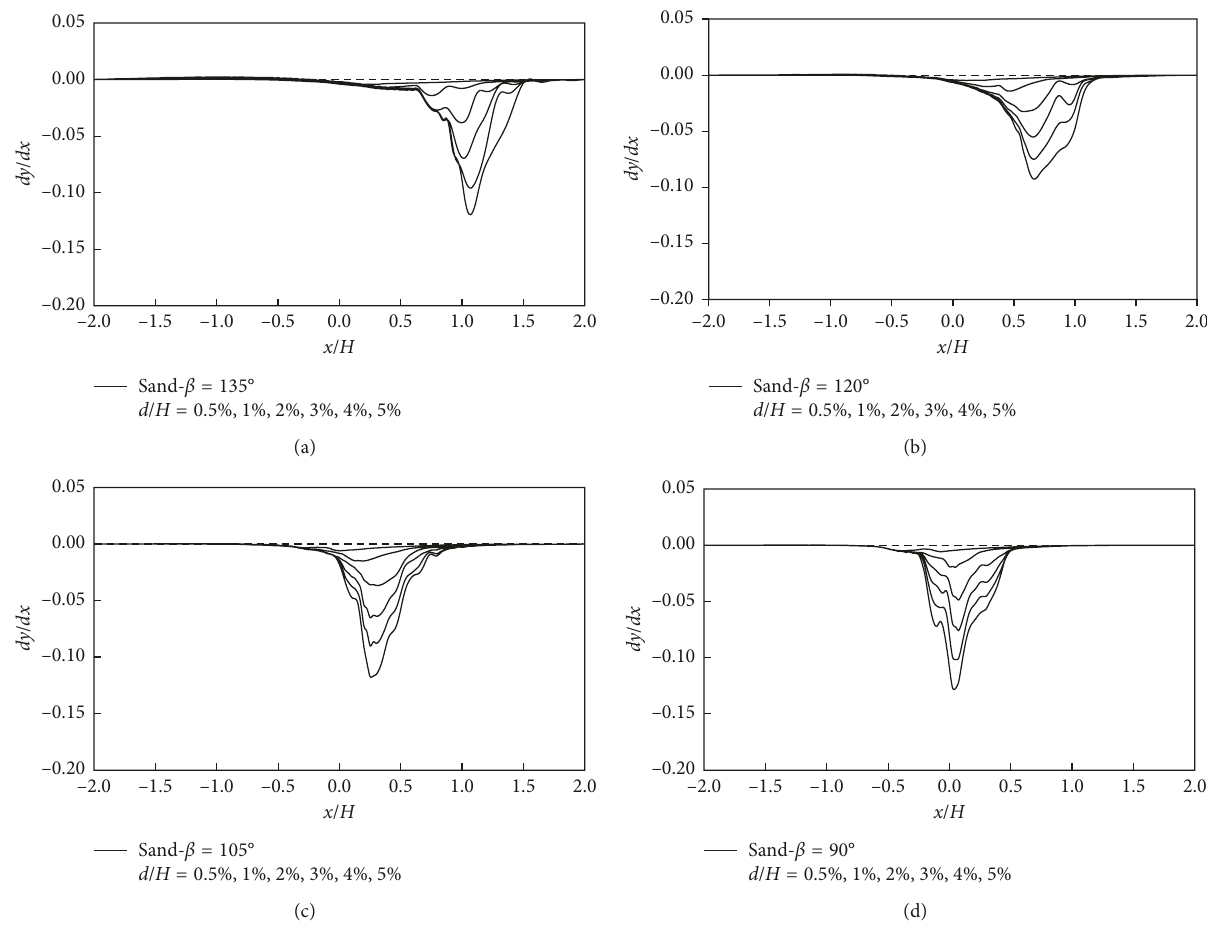
Figure 12: The ground incline curves with different dip angles for the reverse fault in sand: (a) 45 ° , (b) 60 ° , (c) 75 ° , and (d) 90 °